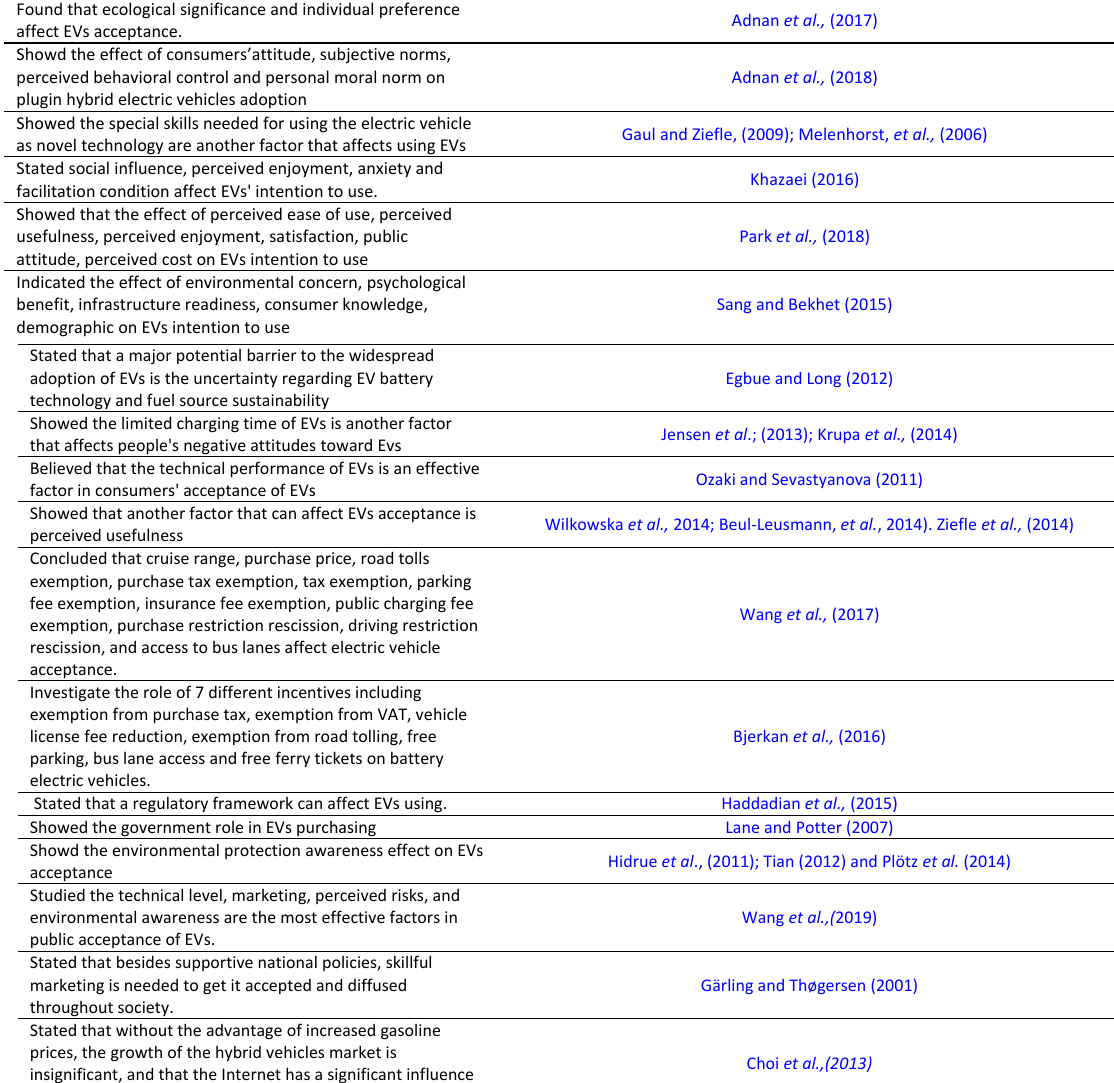
Table 1: important previous studies about EVs acceptance